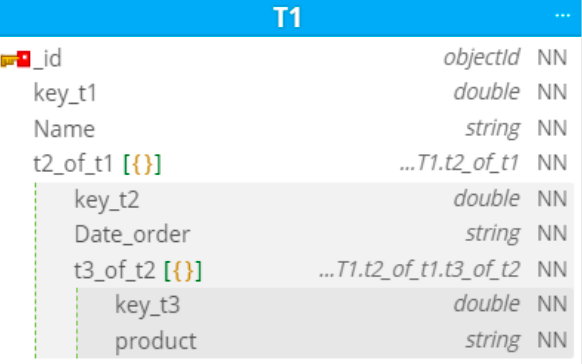
Table 2. The speed of execution of queries to document databases: without embedded documents and with embedded documents.